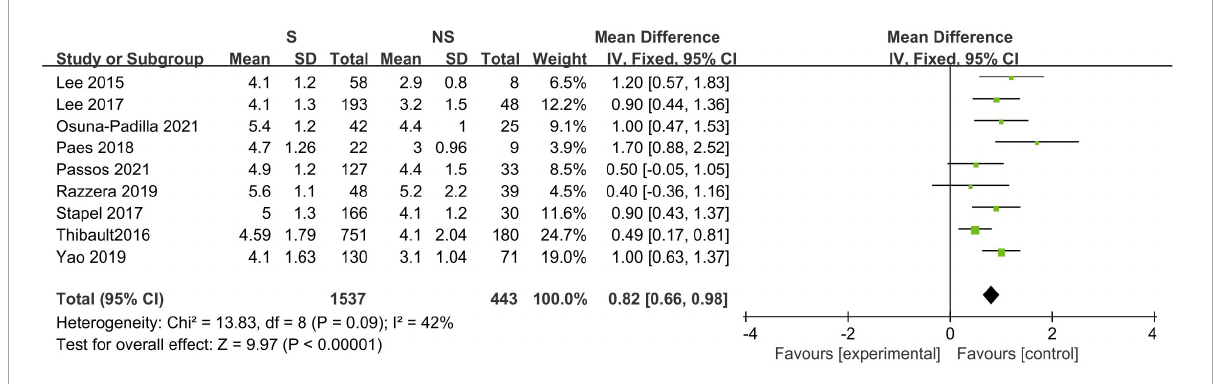
FIGURE3 Forest plot showing the standardized mean phase angle values in the death and survival groups and the pooled